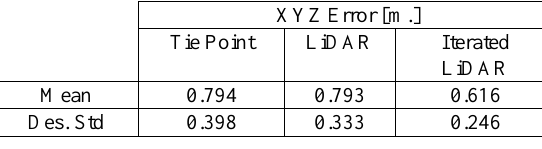
Table 5: 2010 Check Points error values 4.1.2.2. 2008 Flight: The Figure 13 show the evolution of the